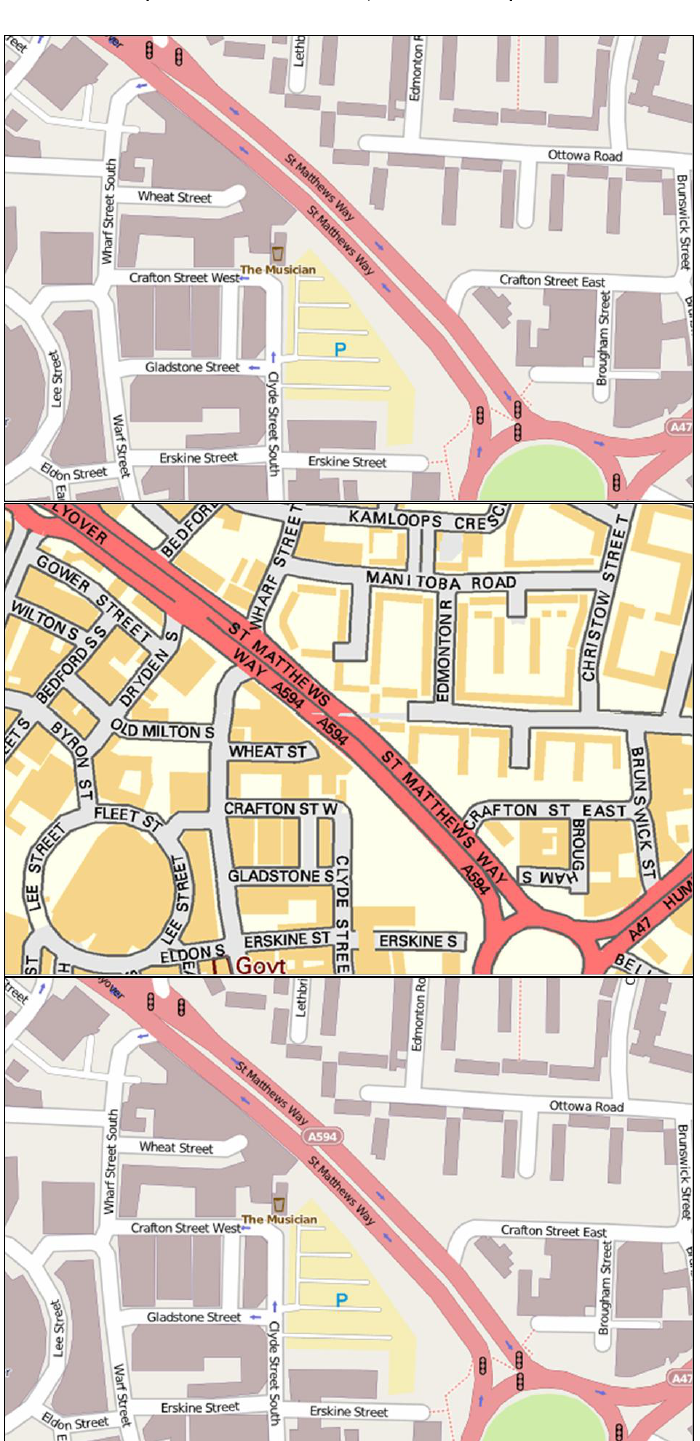
Figure 7. A sample of added road names (A594, in Leicester). ( Top ): original OSM; ( Middle ): OS Open Data map of the same area; ( Below ): updated in